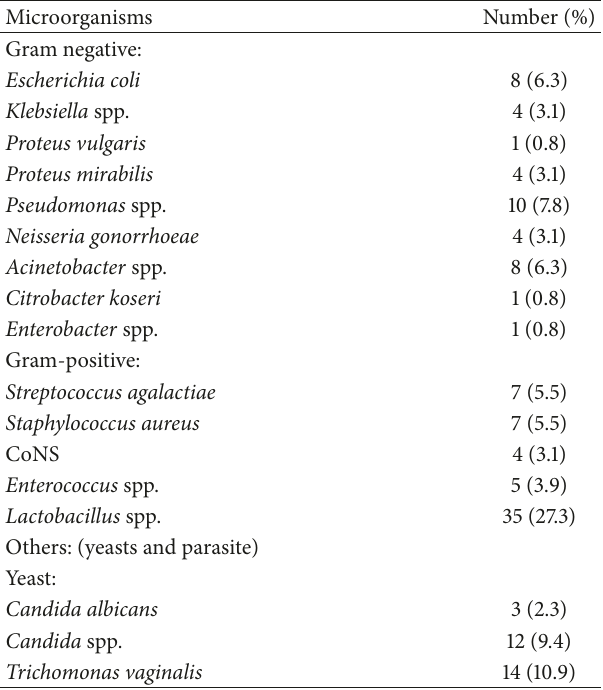
Table 6: Prevalence of microorganisms isolated from vaginal